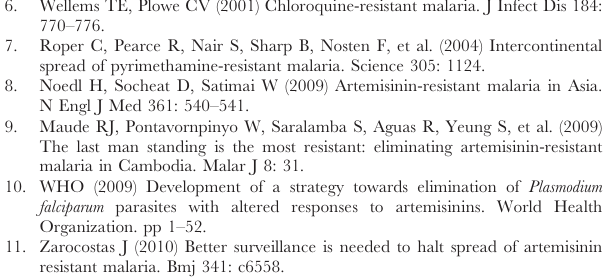
Figure S1 Value of the pfmdr1 copy number in 51 P. falciparum isolates. Each symbol indicates the pfmdr1 copy number in one isolate. Table S1 Primers used in this study. Table S2 In vitro IC 50 s (nM) of cultured field isolates to four antimalarial drugs (mean 6 standard deviation). Table S3 In vitro IC 50 s (nM) of parasite isolates to artesunate (AS), dihydroartemisinin (DHA), mefloquine (MQ) and lumefantrine (LMF) stratified by mutations in pfmdr1 , pfATP6 , pfmdr6 and pfMT